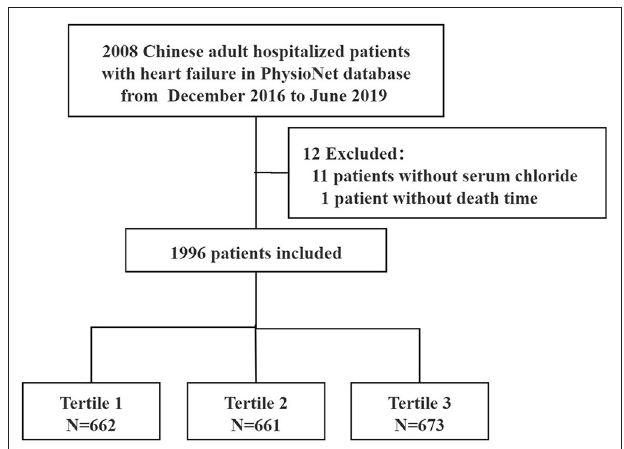
FIGURE 1 | Flow chart of patients selection.